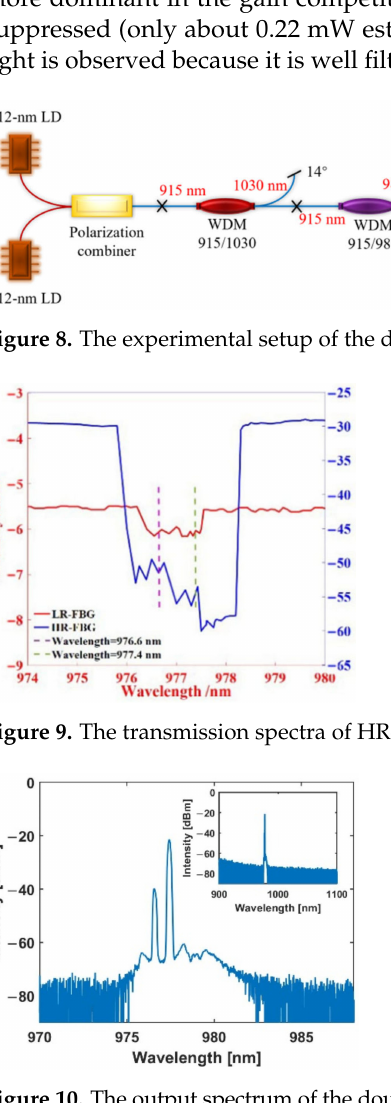
Figure 10. The output spectrum of the double-wavelength fiber oscillator with 160-mW output